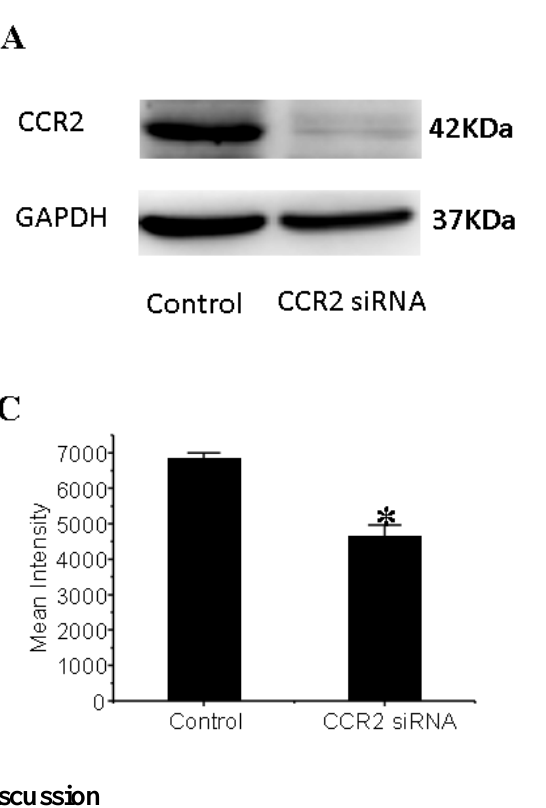
Figure 6. C-C chemokine receptor type 2 (CCR2) inhibition decreases mesenchymal stem cells (MSCs) migration to the dilated heart; ( A ) CCR2 siRNA decreases the expression of CCR2 in MSCs ( B ) Representative photographs of Fluorescence imaging of the migrated GFP-labled control MSCs or CCR2 siRNA MSCs to the dilated heart ( C ) CCR2 inhibition decreases MSCs migration to the dilated heart. * p < 0.01 vs . control. n = 3 per group; An independent-samples t -test was